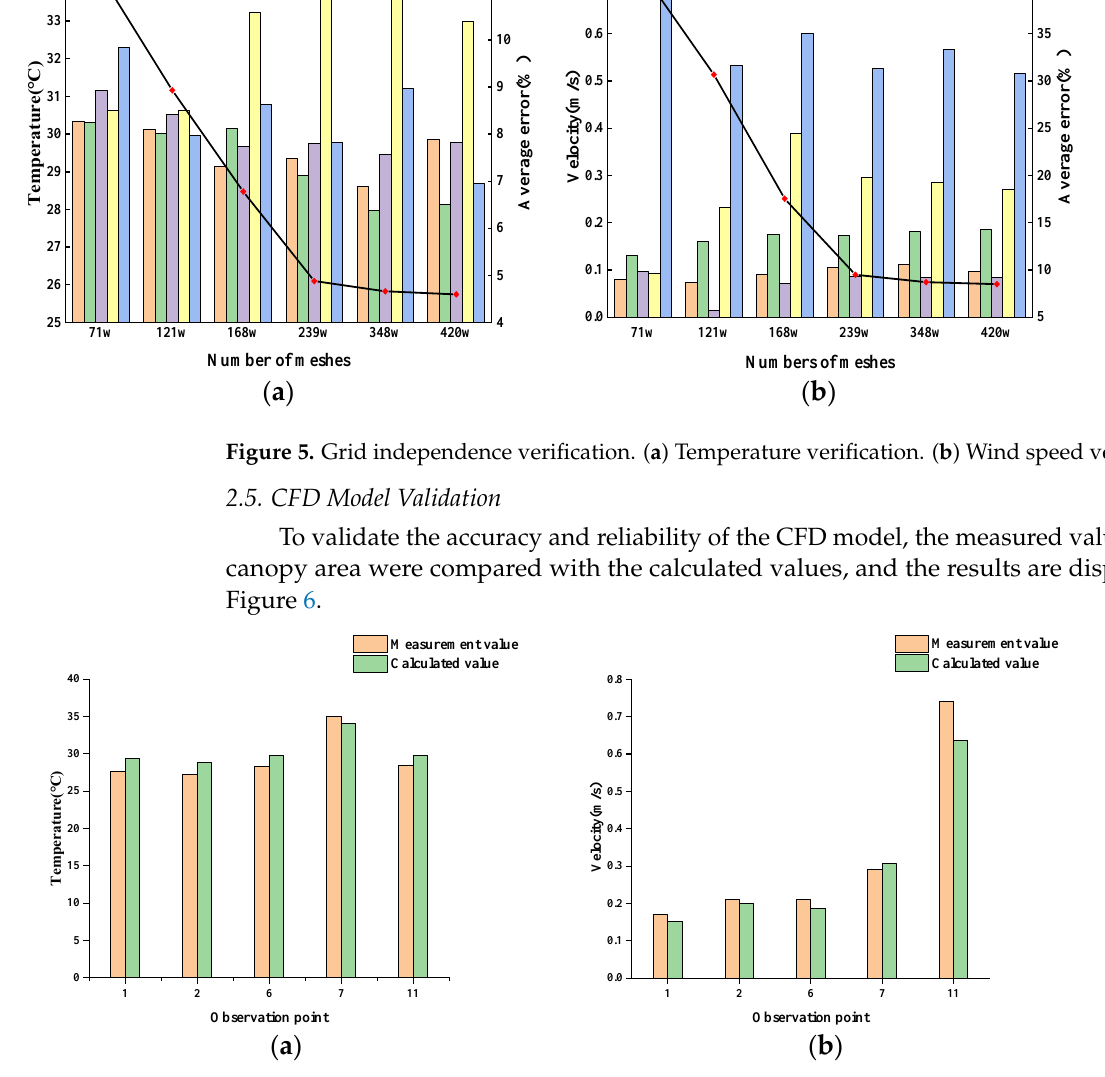
Figure 6. Validation of calculated and measured values. ( a ) Temperature validation. ( b ) Velocity validation. Table 3. CFD Validation.